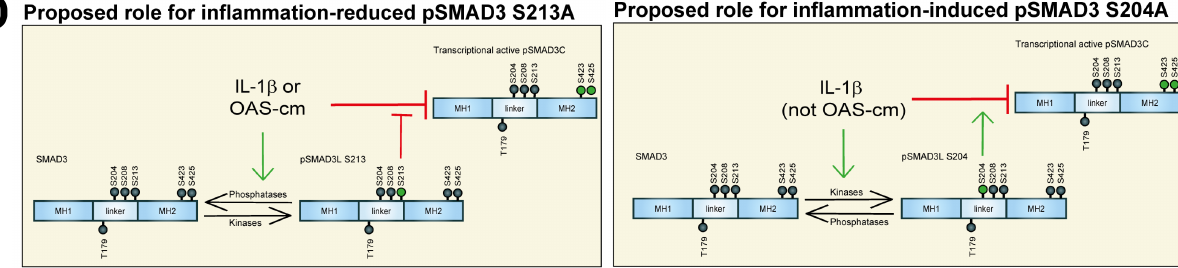
Figure 5. When the SMAD3 linker could not be modified, TGF β transcriptional activity was differently regulated by OA-related inflammation. To study the role of the SMAD3 linker phospho-sites in regulating TGF- β signaling, we made use of individual SMAD3 linker variants. ( A ) Schematic illustration of the different SMAD3 variants which cannot be phosphorylated on specific sites in their linker domain due to mutations from the serines (S) to alanines (A) (S204A, S208A, S213A) and the threonine (T) to a valine (V) (T179V). ( B , C ) SW1353 cells were transfected with the SBE-pNL1.2 construct, re-plated afterwards and transduced with the different SMAD variants. After a 48 h transduction and after overnight serum-starvation, we pre-incubated 1 h with 0.1 ng/mL IL-1 β or 5% OAS-cm and then stimulated with 0.5 ng/mL TGF- β , after which luciferase signal was measured. ( B ) Percentage fold induction compared to medium was depicted, relative to experimental condition stimulated with 0.5 ng/mL TGF- β set at 100% (ctrl level). Data represent mean ± SD of four independent experiments performed in quadruple. ( C ) The percentage inhibition of 0.5 ng/mL TGF- β with 0.1 ng/mL IL-1 β or with 5% OAS-cm was calculated and compared between the normal SMAD3 transduced cells and the conditions transduced with the SMAD linker mutants. Every dot represents one independent experiment performed in quadruple. Statistical analysis was performed using a one-way ANOVA with Dunnett’s multiple comparison test. ns— non-significant; * p ≤ 0.05; ** p ≤ 0.01; *** p ≤ 0.001; **** p < 0.001. ( D ) Summarized findings regarding the effect of inflammation-induced dephosphorylation of SMAD3L S213 on SMAD2/3 transcriptional activity and the hypothetical role of IL-1 β -induced S204 linker modification. Green arrows represent activation and red “T” shapes represent